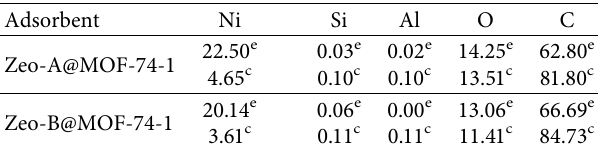
e � edge, c � center.